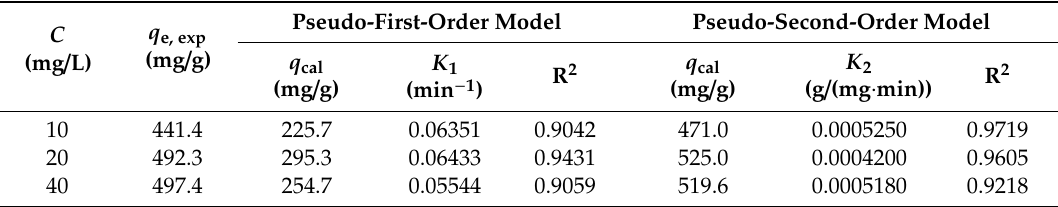
Table 1. Kinetic parameters obtained from pseudo-first-order and pseudo-second-order for the adsorption of divalent mercury (Hg(II)) by the biopolymer for di ff erent initial Hg(II)